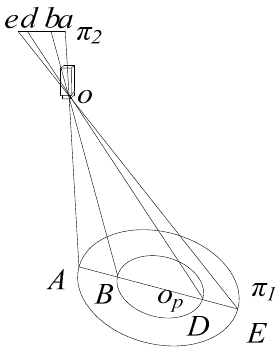
Figure 4. Concentric circle target.